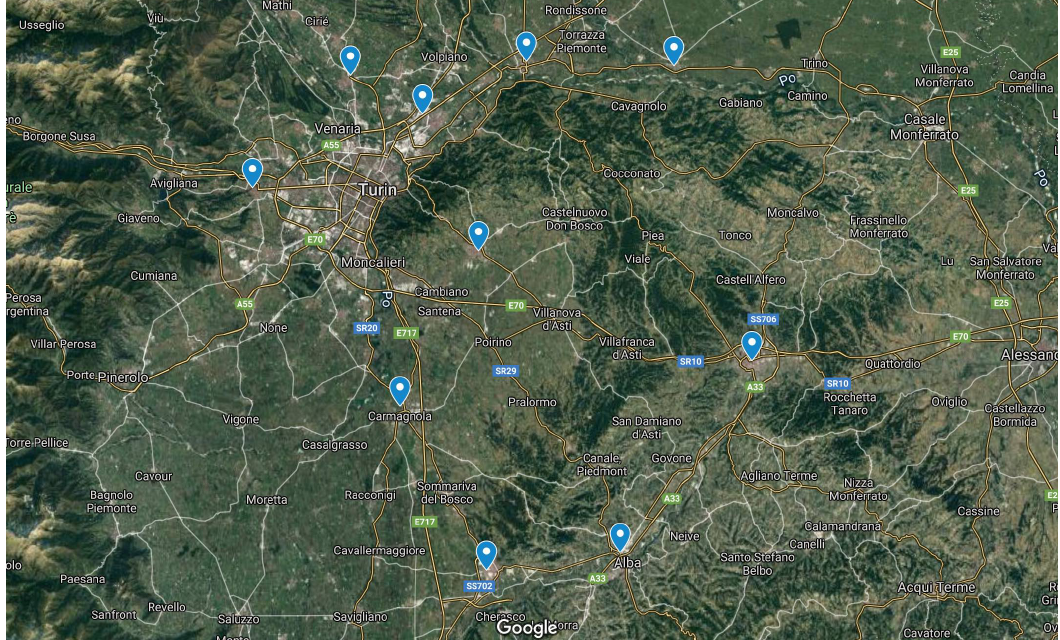
Figure 11. Destinations for deliveries on real